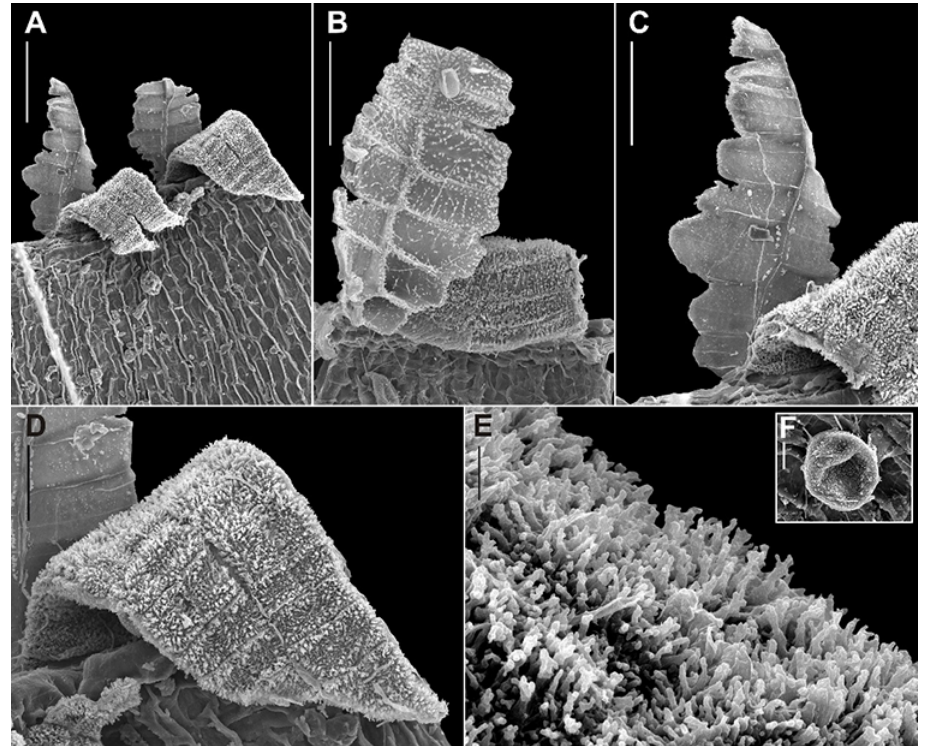
Figure 2 Scanning electron microscopy micrographs of Lewinskya graphiomitria , showing a portion of the double peristome ( A ), IPL (inner peristome layer) ornamentation of an endostome segment ( B ), PPL (primary peristome layer) ornamentation of an endostome segment ( C ), PPL ornamentation of an exostome tooth ( D ), papillae on the OPL (outer peristome layer) side of exostome tooth ( E ), and a spore ( F ). Scale bars: ( A ) 100 µ m; ( B−C ) 50 µ m; ( D ) 20 µ m; ( E ) 5 µ m; ( F ) 10 µ m. All from Guo & Cao s.n., September 15, 2012, OSTR